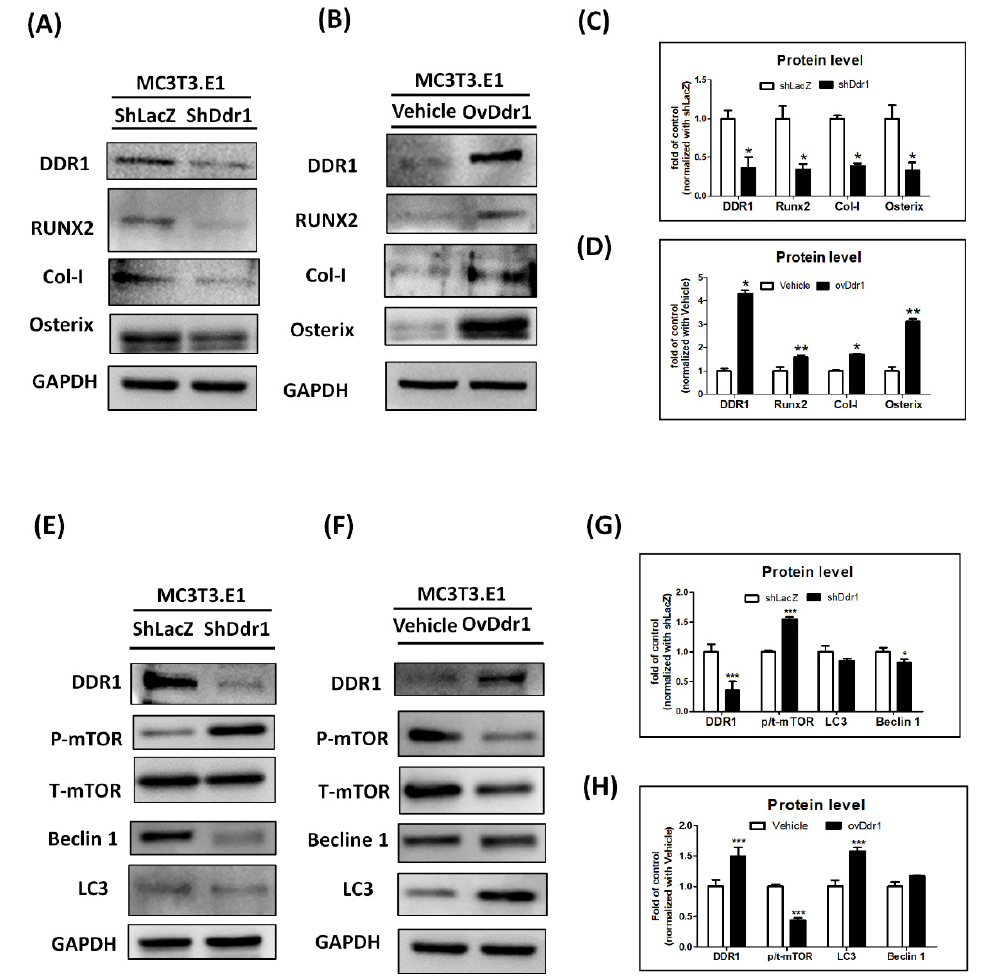
Figure 7. DDR1 enhanced osteogenesis and decreased autophagy in MC3T3-E1 cells. ( A , B ) West- ern blotting against DDR1, RUNX2, Col-I, osterix, and GAPDH in MC3T3-E1 cells infected with shLacZ/shDDR1 and Vehicle/ovDDR1. ( C , D ) Quantitation results of DDR1, RUNX2, Col-I, and os- terix for shDDR1 compared with those of shLacZ and ovDDR1 compared with those of the vehicle. ( E , F ) Western blotting against DDR1, p-mTOR, t-mTOR, beclin-1, and LC3 in MC3T3-E1 cells infected with shLacZ/shDDR1 and Vehicle/ovDDR1. ( G , H ) Quantitation of the results for shDDR1 compared with those for shLacZ and ovDDR1 compared with those of the vehicle. This experiment was performed in quadruplicate and repeated three times with similar results. ShLacZ/Vehicle: the transduction by empty lentivirus; RUNX2: runt-related transcription factor 2; Col-I: collagen I; Osx: osterix; GAPDH: glyceraldehyde 3-phosphate dehydrogenase; p-mTOR: phosphorylation of the mechanistic target of rapamycin; t-mTOR: total of the mechanistic target of rapamycin; LC3: light chain 3 (* p < 0.05 versus shLacZ or Vehicle, ** p < 0.01 versus shLacZ or Vehicle, *** p < 0.001 versus